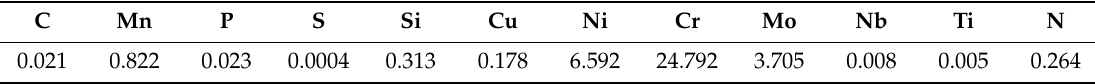
Table 3. Mechanical properties of the 2507-type SDSS.